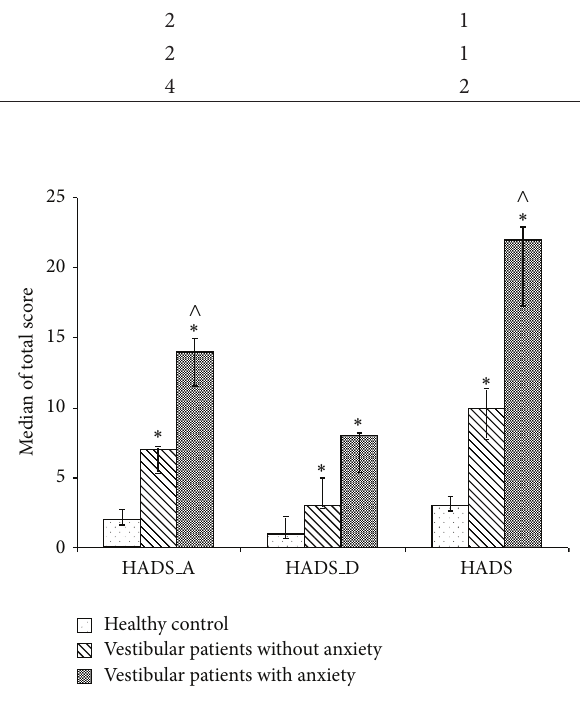
Figure 1: Median values and 95% confidence interval for HADS-A, HADS-D, and HADS scores for healthy subjects, vestibular patients without anxiety, and vestibular patients with anxiety. ∗ Significance between healthy subjects and vestibular patients, 𝑃 < 0.05 and ∧ significance between both vestibular patients groups, 𝑃 < 0.05 (Mann-Whitney 𝑈